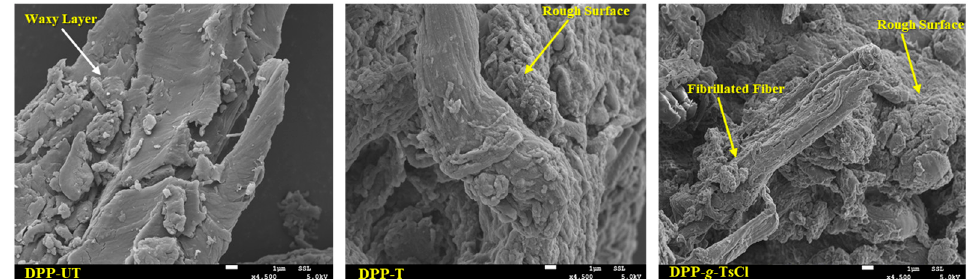
Figure 7. SEM images of the untreated, treated, and functionalized fillers.